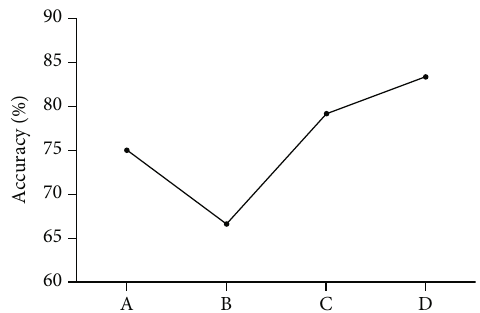
Figure 3: Visualization of classi fi cations in SVM by using GFC in the di ff erent brain regions: (a) right SFG; (b) bilateral superior MPFC/ACC; (c) left paracentral lobule/SMA; (d) right precentral gyrus/postcentral gyrus/paracentral lobule. SVM: support vector machine; GFC: global-brain functional connectivity; SFG: superior frontal gyrus; MPFC: medial prefrontal cortex; ACC: anterior cingulate cortex; SMA: supplementary motor area.